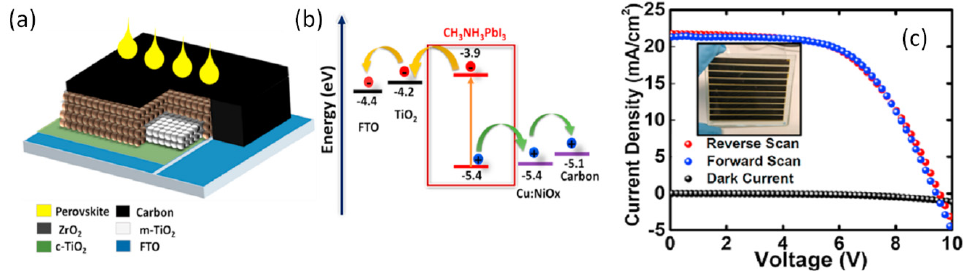
Figure 21. ( a ) Schematic illustration of the device architecture. ( b ) Work function of different layers. ( c ) Forward and reverse scan of device with Cu:NiOx layer with an aperture area of 70 cm 2 under 1 sun illumination [99]. (Reproduced from Ref. [99], 10.1016/j.solener.2019.02.056, with permission.)